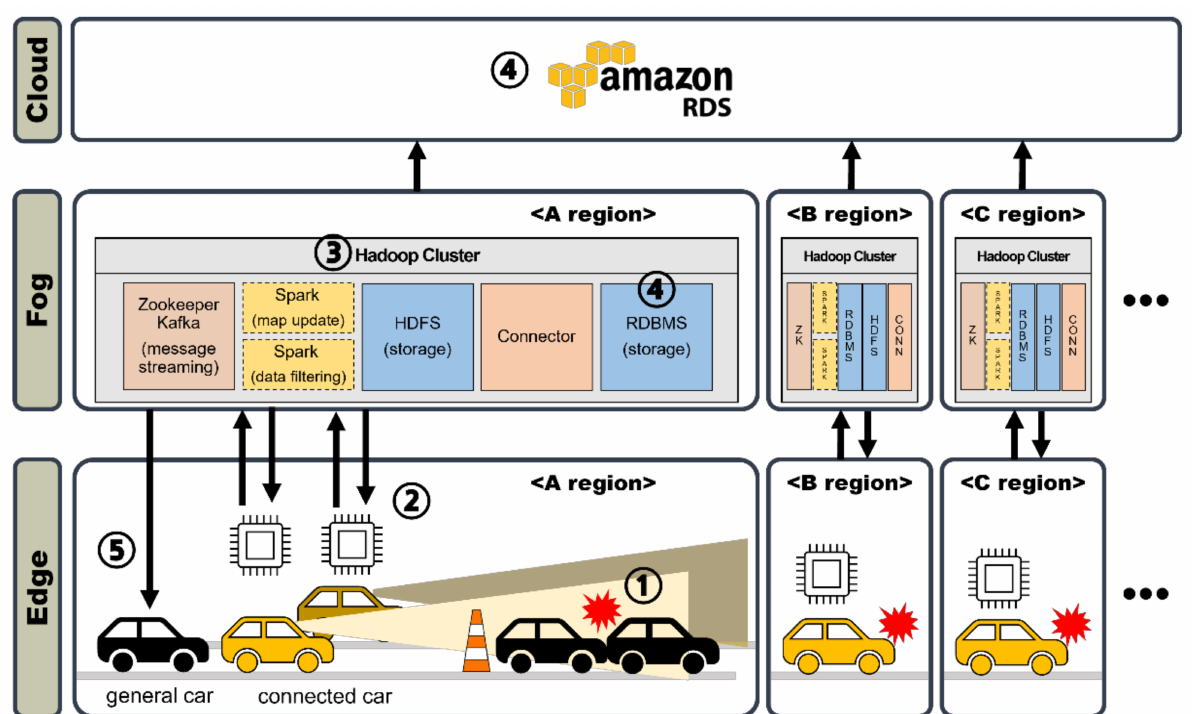
Figure 1. Edge-fog-cloud dynamic object mapping